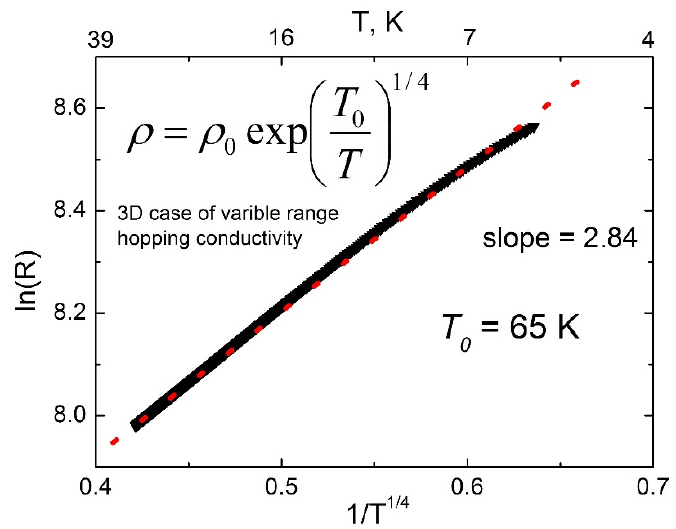
Figure 14. Fitting of temperature dependence of resistance of Fe 3+ x Si 1 − x /Ge(4 nm)/Fe 3+ x Si 1 − x etched